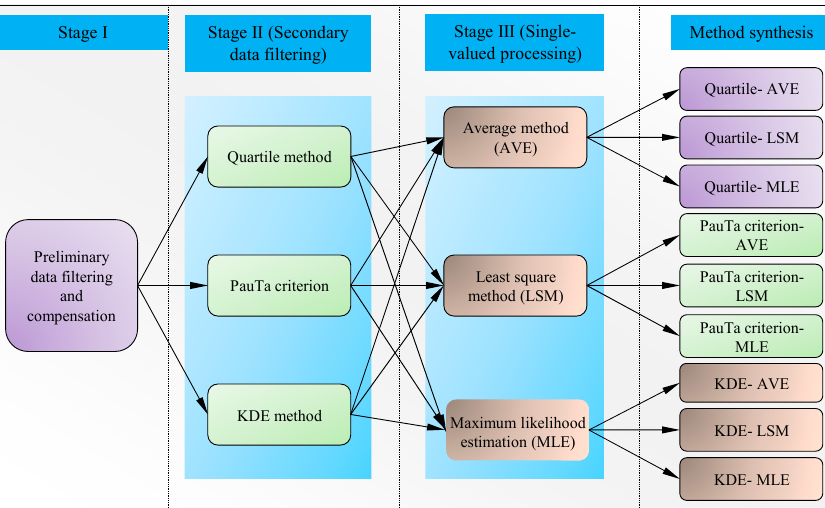
Figure 6. Synthesis of data processing methods.